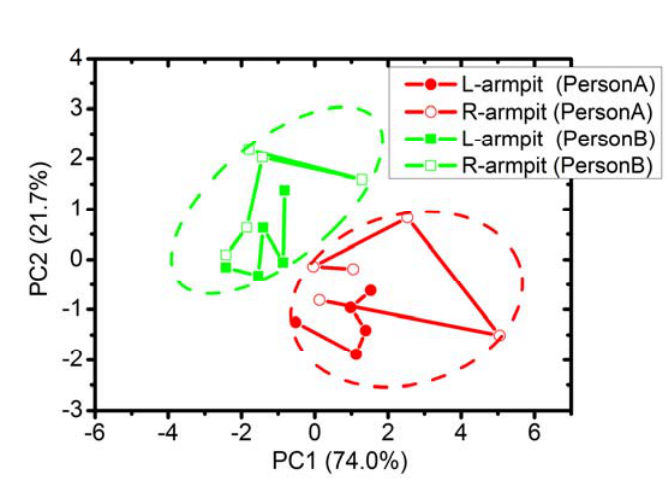
Figure 7. The 2D-PCA of armpit odors from two persons as measured in the afternoon during 5